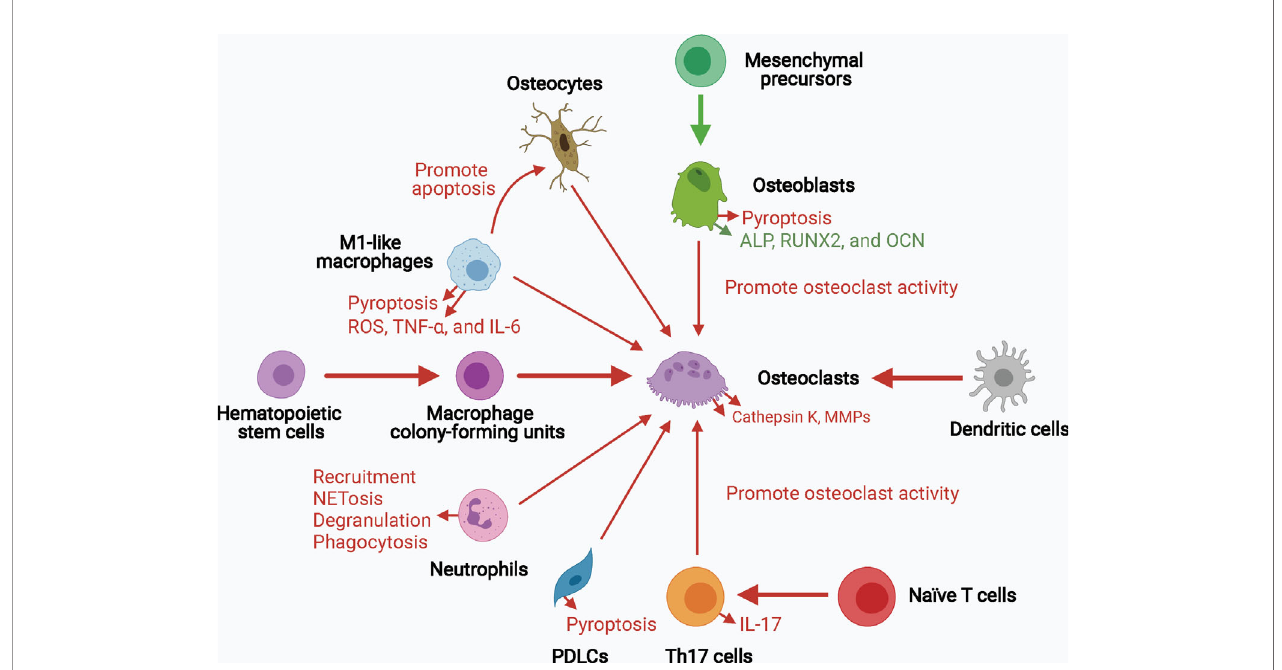
FIGURE 3 | The role of in fl ammasome activation in the crosstalk of bone remodeling factors. In fl ammasome activation promotes osteoclast activity by upregulating their differentiation from hematopoietic stem cells and dendritic cells, and enhancing their bone resorption ability. Osteoblasts, osteocytes, macrophages, neutrophils, PDLCs, and Th17 cells can also promote osteoclast activity in the context of in fl ammasome activation. The decreased osteogenesis and increased pyroptosis of osteoblasts and periodontal ligament cells downregulate bone formation and upregulates periodontium in fl ammation. Upregulated processes associated with increased in fl ammasome activation are marked in red, and downregulated processes are marked in green. ALP, alkaline phosphatase; MMPs, matrix metalloproteinases; OCN, osteocalcin; PDLCs, periodontal ligament cells; ROS, reactive oxygen species; RUNX2, runt-related transcription factor 2; Th17 cells, T helper 17